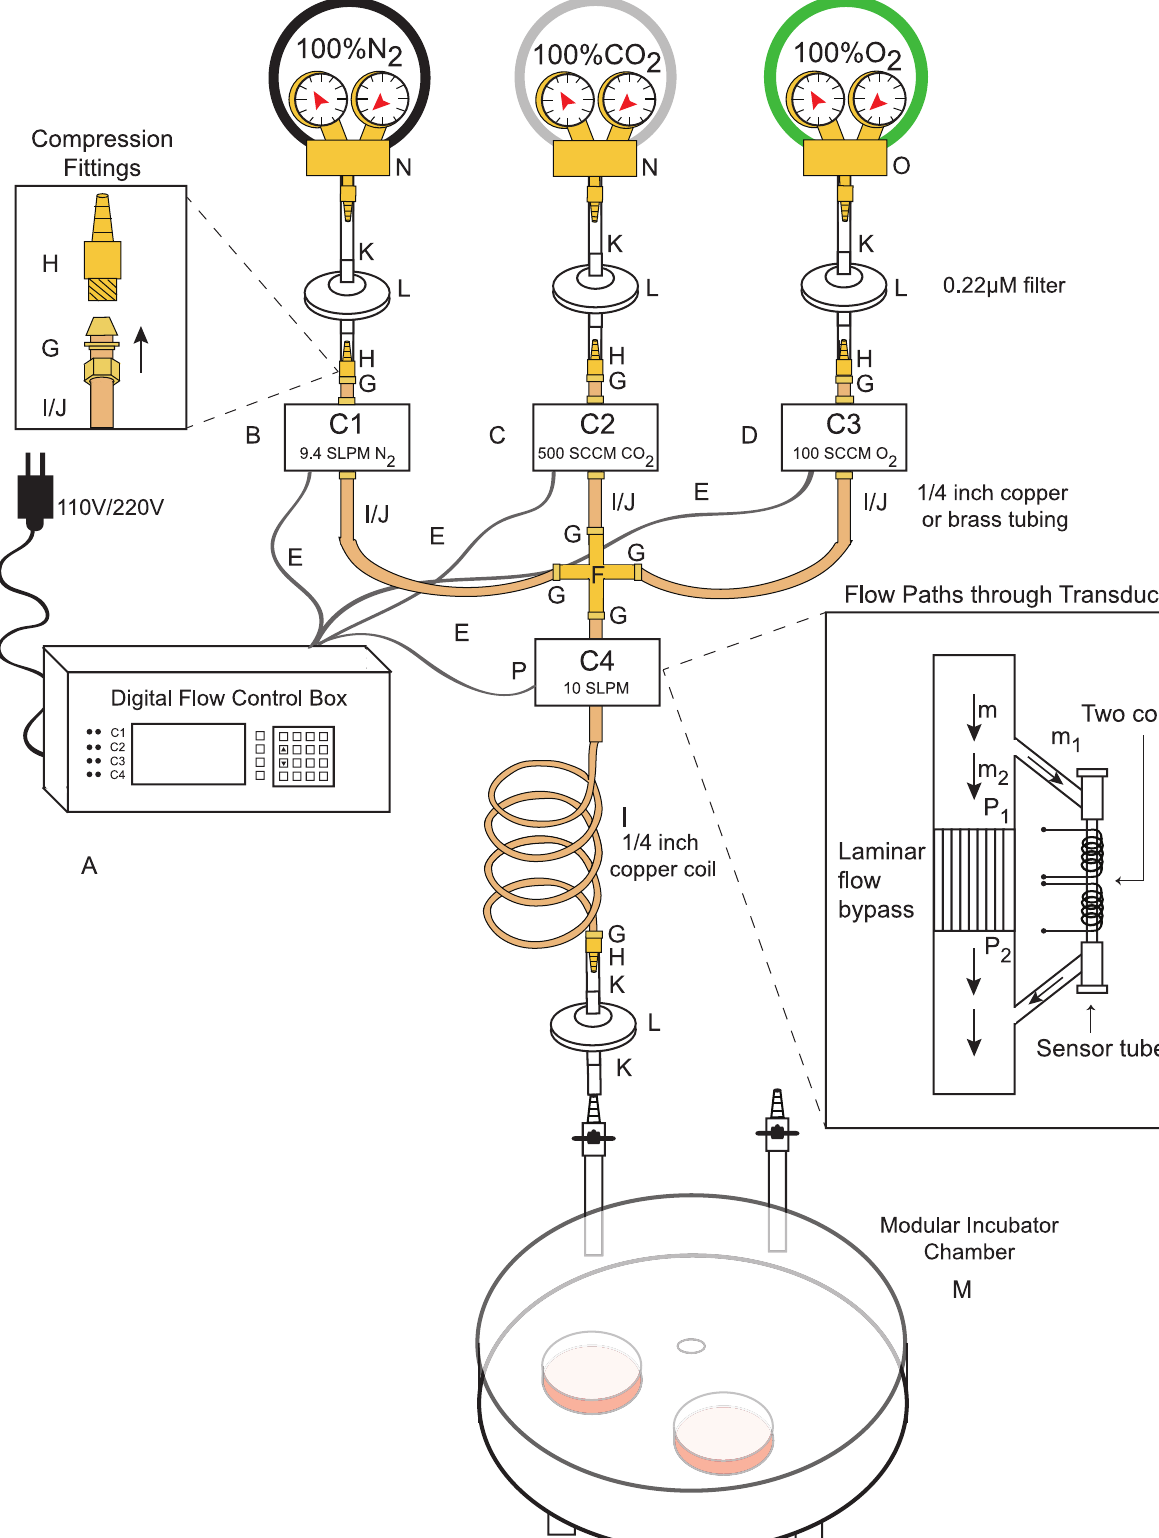
Figure 1. Diagram of digital flow control box with flow controllers. A diagram showing the set up of the digital control box and gas flow controllers. Inset diagrams the principle of the flow controls as adapted from the manual. Individual parts are detailed in Table 1 in addition to as follows: A: Model 954 Digital Flow Box, B: 840L Mass Flow Controller –10 SLPM (N 2 ) capacity, C: 840L Mass Flow Controller –1000 SCCM (CO 2 ) capacity, D: 840L Mass Flow Controller –1000 SCCM (O 2 ) capacity, E: 840-CDCL (15 ft) Cable, F: Compression fitting Union Cross, G: Compression